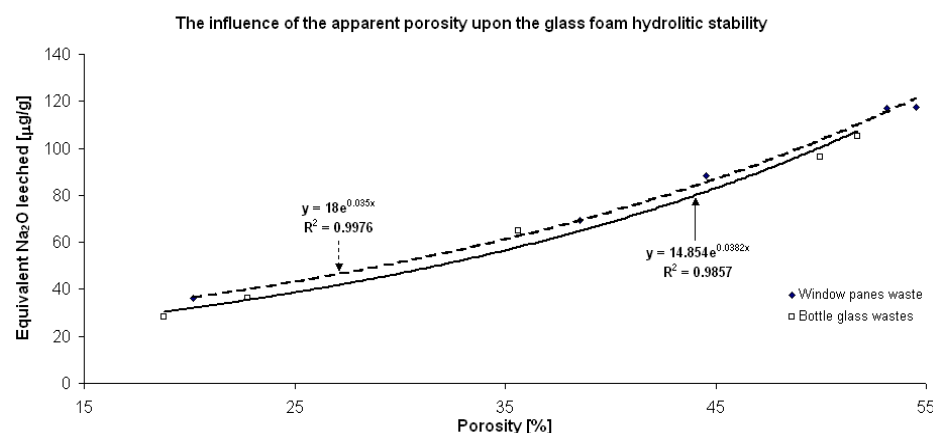
Figure 3. The influence of the glass apparent porosity upon its hydrolytic